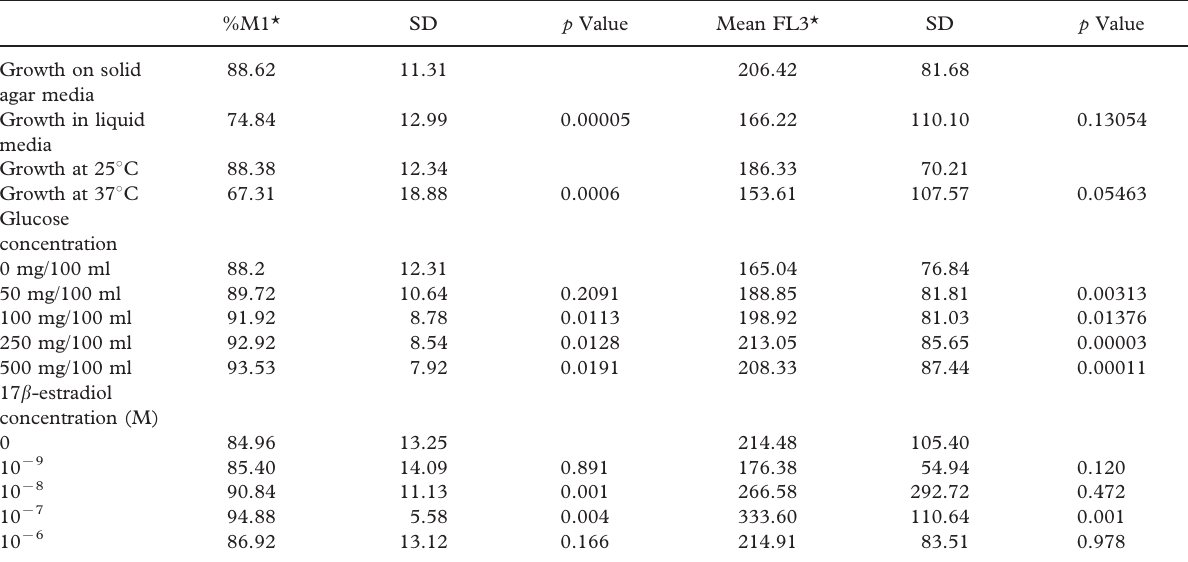
Table III. Effect of environmental conditions on yeast